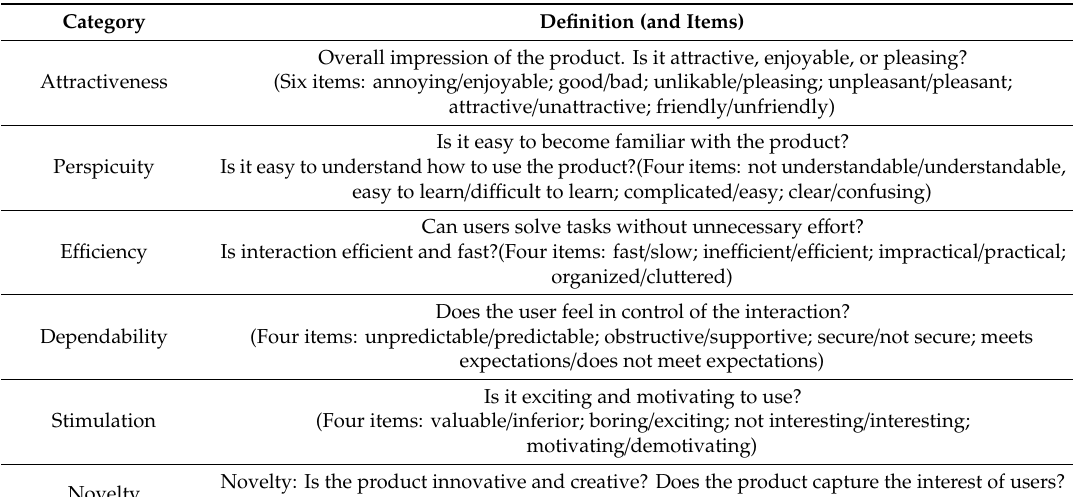
Table 3. Questionnaire categories and definitions (and items) for user